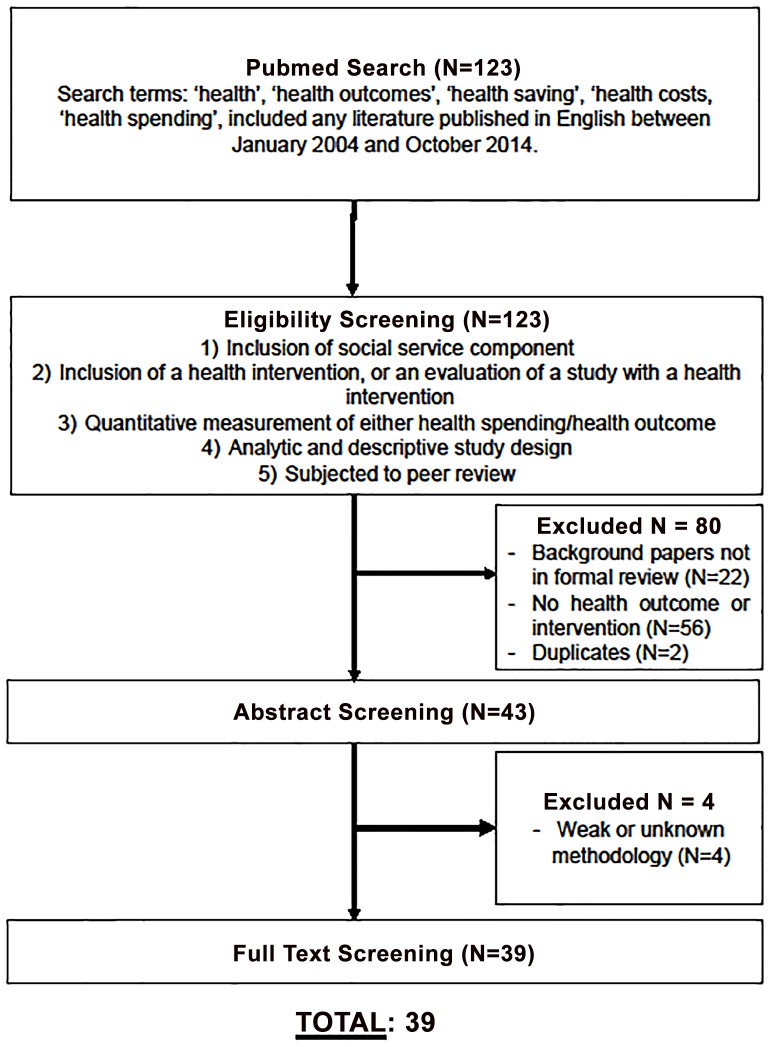
Sampling Schematic.